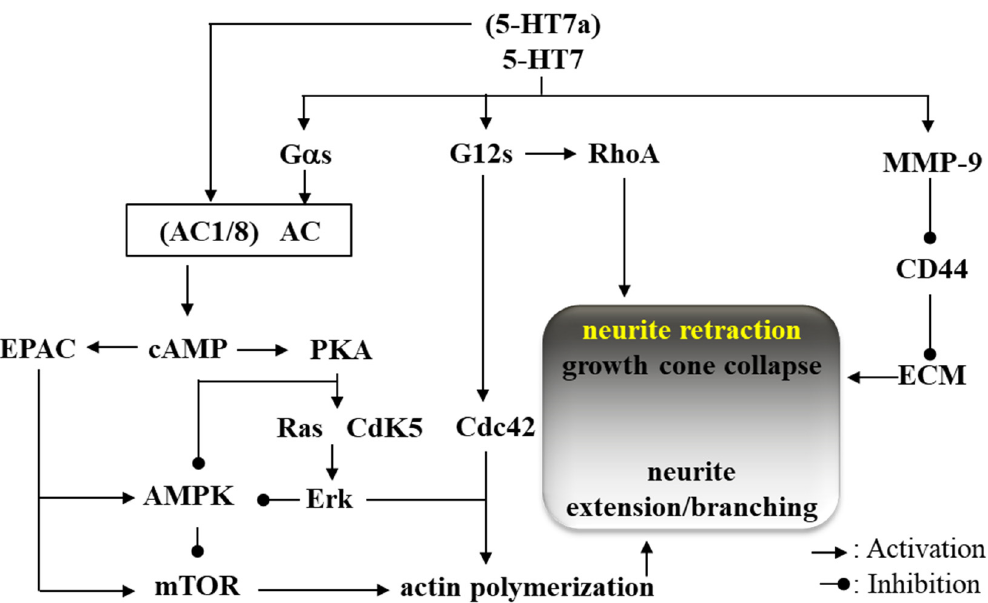
Figure 1. Intracellular signalling associated with 5-HT7. AC, adenylyl cyclase; AMPK, adenosine monophosphate-dependent protein kinase; cAMP, cyclic adenosine monophosphate; Cdc42, cell division cycle protein 42; Cdk5, cyclin-dependent kinase 5; EPAC, exchange protein directly activated by cAMP; Erk, extracellular-regulated kinase; mTOR, mammalian target of rapamycin; PKA, protein kinase A; RhoA, Ras homolog gene family member A; CD44, hyaluronic acid receptor; MMP-9, metalloproteinase 9; ECM, extracellular matrix.